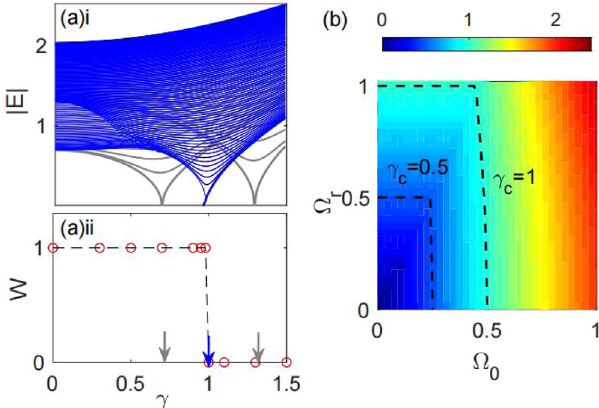
Fig. 4 Topological phase transition for case-III with ϕ r = π , ϕ 0 = π /2. a (i, ii) The amplitude of spectrum ∣ E ∣ under open boundary condition (blue) and the winding number W obtained from ed Brillouin zone as functions of γ . Here we take Ω 0 = 0.5, Ω r = 0.3. The topological transition occurs at γ c ~ 1, which differs from the periodic boundary condition predictions γ = 0.7, 1.3 (gray arrows). The periodic boundary condition eigen- c , PBC spectrum is shown in gray for comparison. b Contour plot of γ c in ( Ω 0 , Ω r ) plane (here the color bar represents the value of γ c ). The energy unit is taken as hopping t